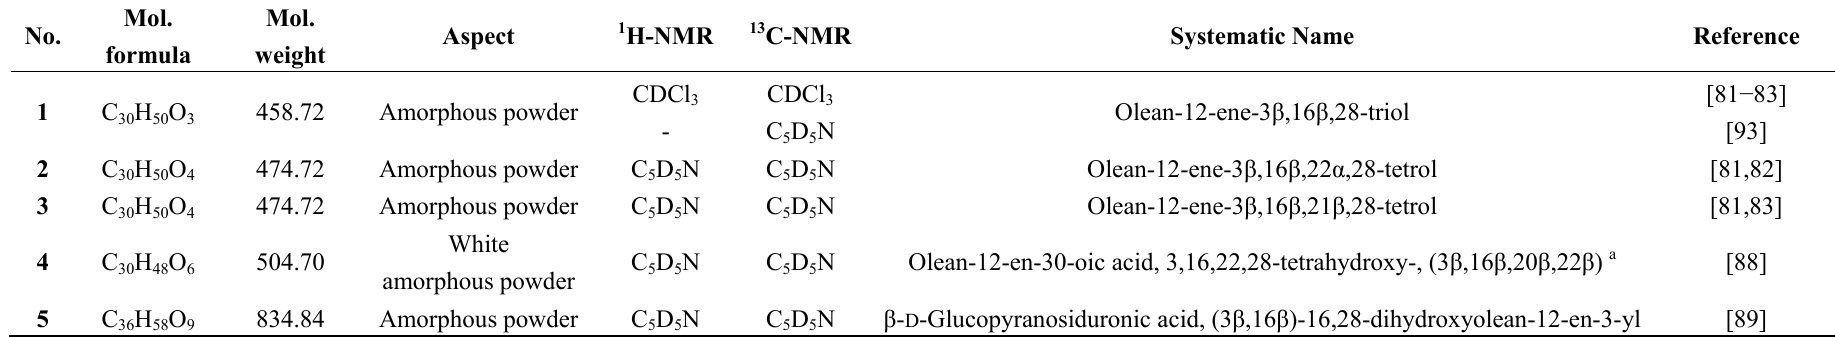
Table 6. Systematic names and chemical and spectral data of compounds 1 – 16